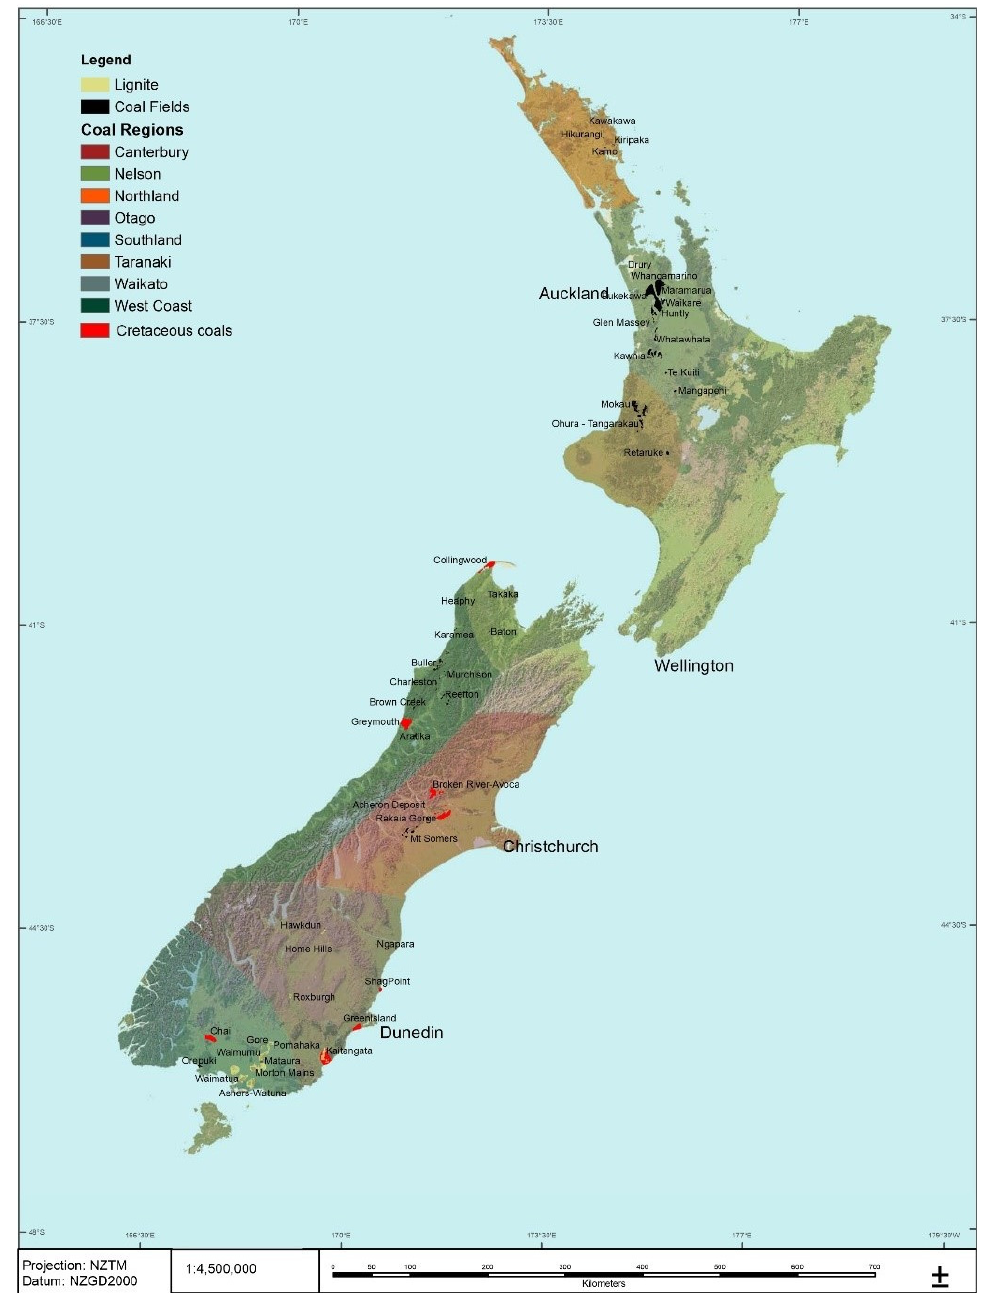
Figure 23. New Zealand Cretaceous coalfields (after New Zealand Petroleum and